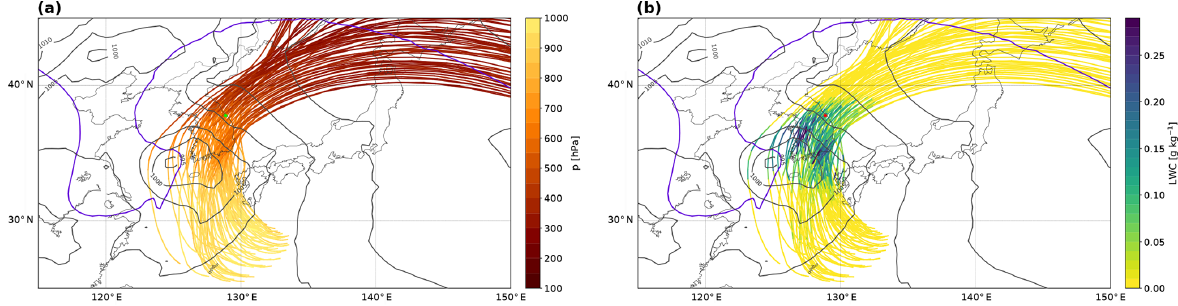
Figure 3. WCB trajectories with an ascent rate of at least 600hPa in 48h that are located near the measurement site at 06:00UTC on 28 February 2018. Colours indicate (a) the pressure level and (b) the LWC along the WCB air parcels. Also shown are sea level pressure (grey contours, every 5hPa) and the dynamical tropopause at 315K (purple). Only the WCB trajectories close to the site (green asterisk in panel a and red in panel b ) are